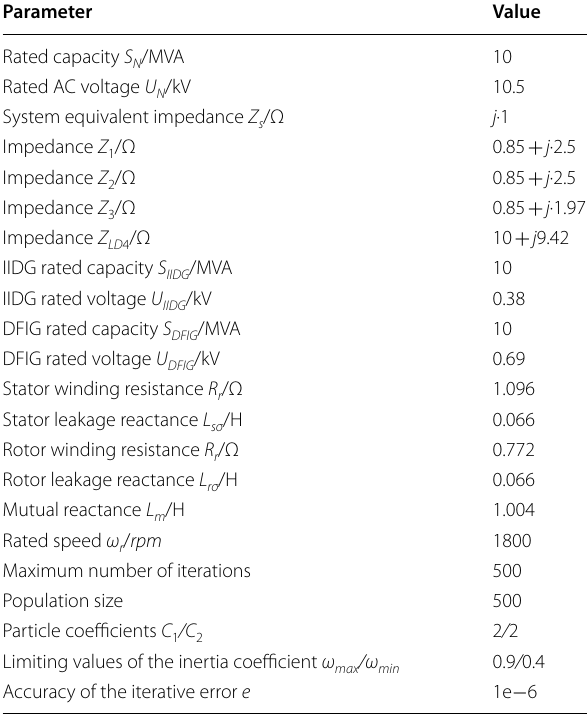
Table 3 Main parameters of the simulation system